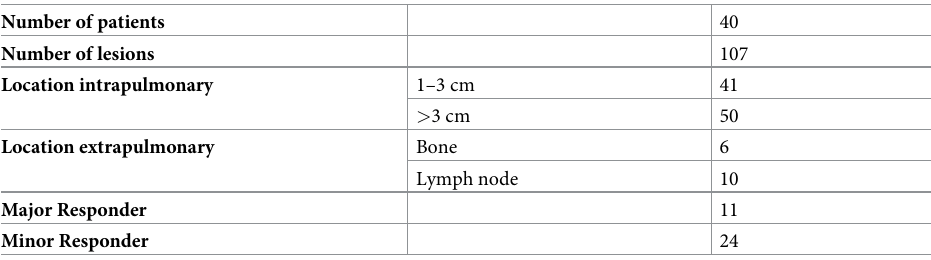
Table 1. Patient number and lesion